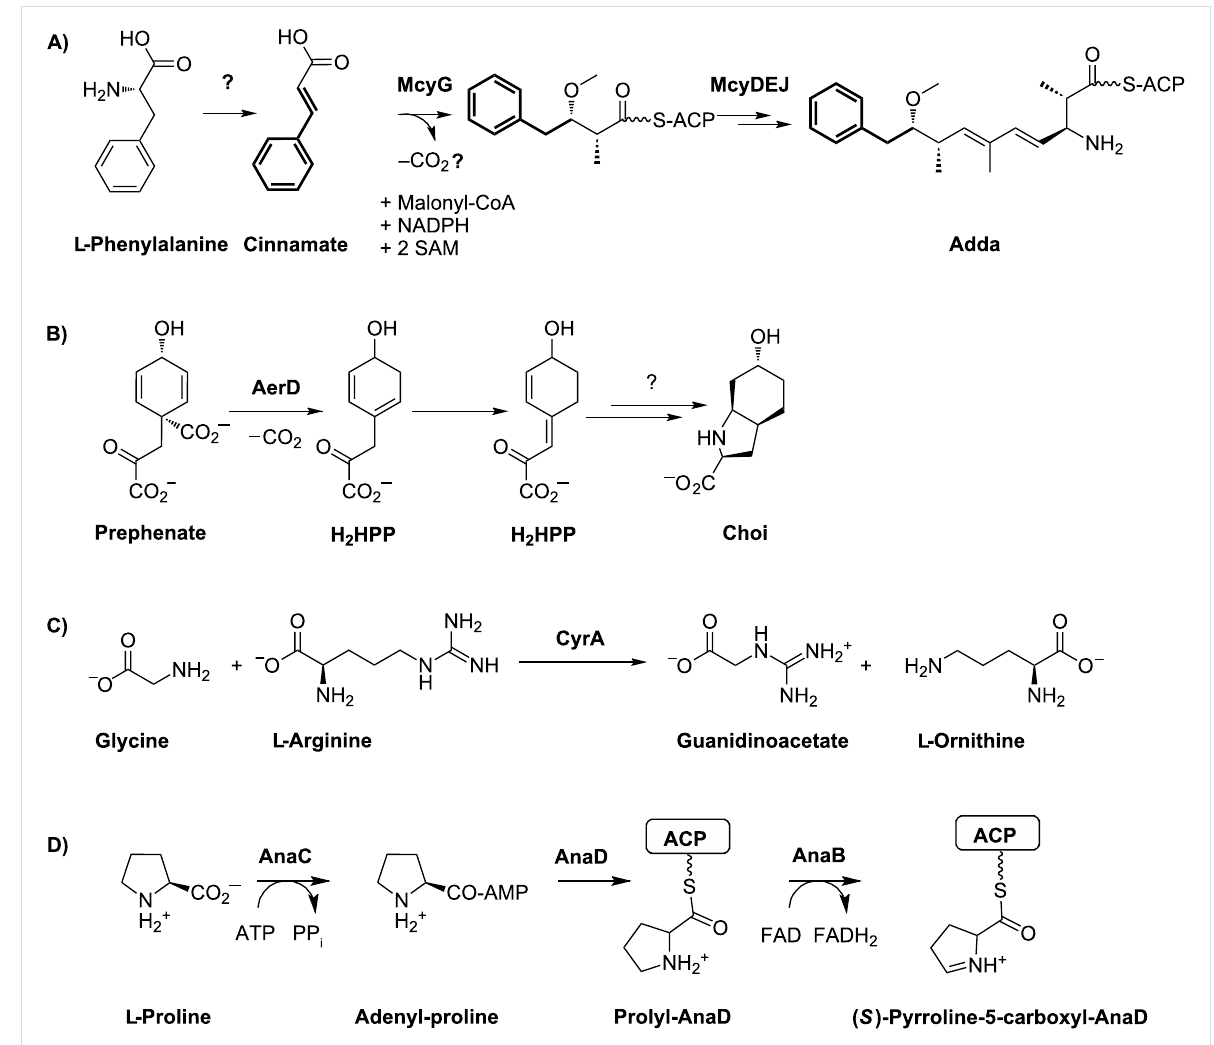
Figure 4: A) Synthesis of the Adda ((2 S ,3 S ,8 S ,9 S )-3-amino-9-methoxy-2,6,8-trimethyl-10-phenyl-4,6-decadienoic acid) moiety of microcystin ( 1 ) starting with cinnamate. The mechanism of α -carbon decarboxylation has to be elucidated. B) Synthesis of the Choi moiety of the aeruginosin 3 . H 2 HPP: Dihydro-4-hydroxyphenylpyruvate. C) Formation of the guanidinoacetate starter unit for the subsequent PKS assembly line of cylindrosper- mopsin ( 4 ). D) Formation of the ( S )-pyrroline-5-carboxylate starter unit from proline in anatoxin-a ( 6 ) synthesis. ACP: Acyl carrier